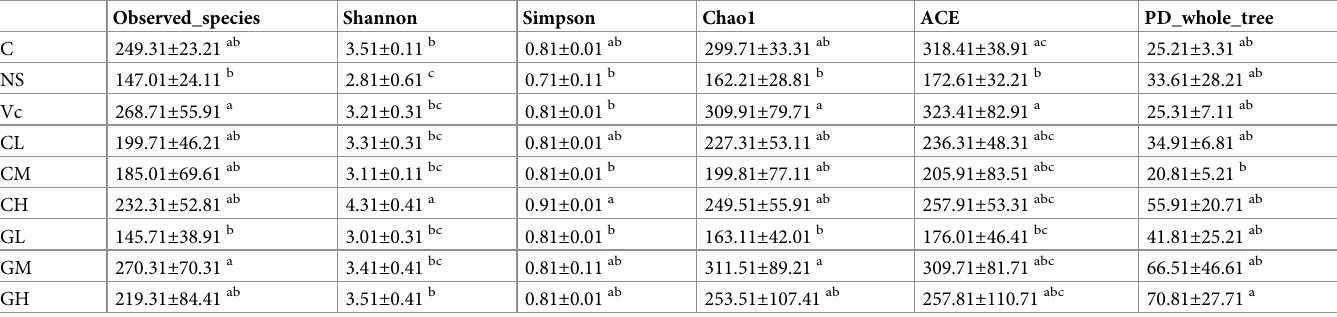
NC: Normal control; NS: Negative control, normal saline treatment; Vc: Positive control, vitamin C treatment; CL, CM, CH represents low-, middle-, high- concentration cow intervention group, respectively. GL, GM, GH represents low-, middle-, high-concentration GWP intervention group,